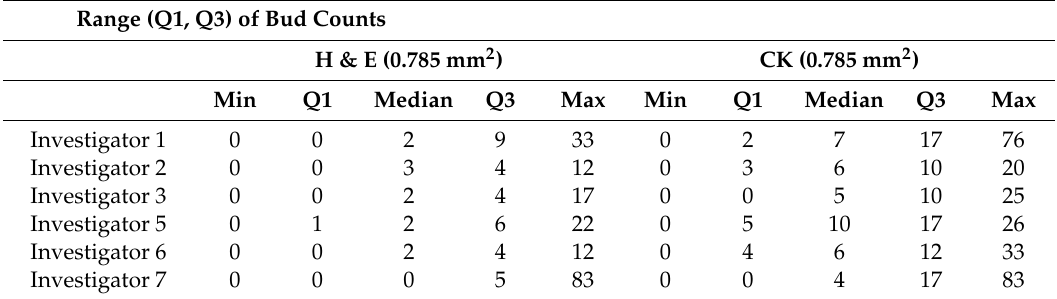
Table 3. Overview of the median, minimum, maximum, and interquartile.